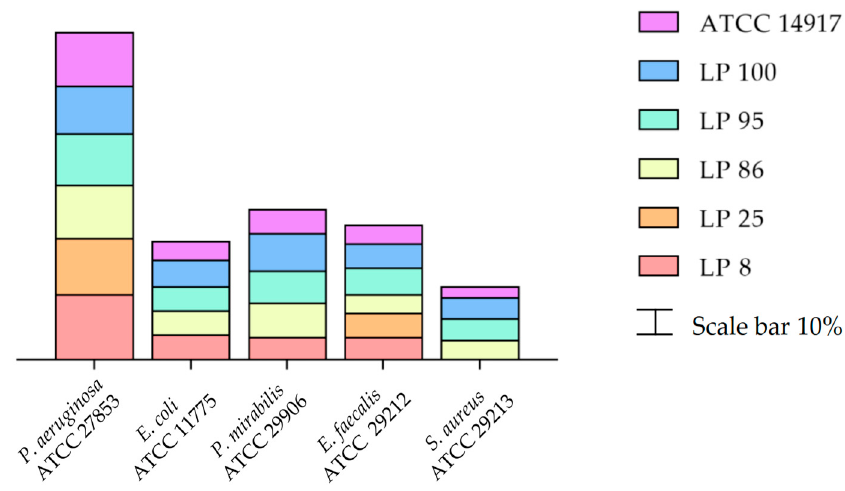
Figure 1. Antimicrobial activity of the L. plantarum strains CFS against different indicator bacteria expressed as inhibition rate (%).